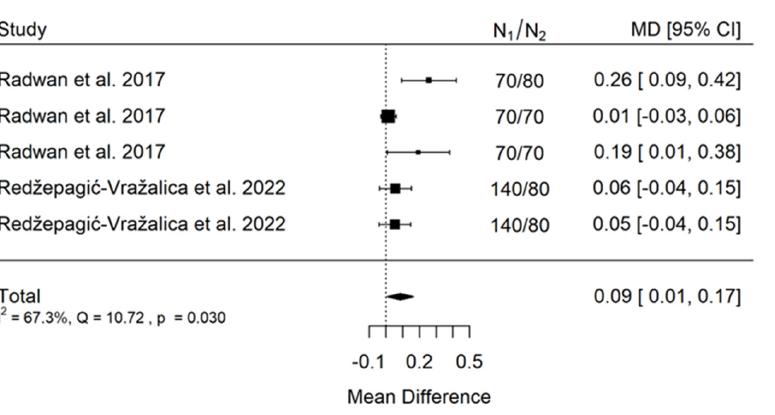
Figure 13. Funel plot for evalutaion of thread shape factor infulence on pull-out strentght in animal bone model studies. 4. Discussion Although there are many systematic reviews concerning different geometric charac- teristics of OMIs, the present paper is the first referring to their minidesign. First of all, it should be pointed out that no clinical study considering the number of threads, threads depth, or TSF has been found in the literature. The only papers found correlating the minidesign of OMIs to their physical characteristics are animal studies, in-vitro studies, and 3D finite element analysis. Thus, the authors of the present systematic review must have based their clinical recommendations on indirect evidence. Moreover, there is a well-designed split-mouth study discussing other factors, that may influence OMI stability, for instance, chemical treatment of screw surfaces [44]. An- other study shows that increasing penetration depth of OMIs results in better retention [45], whereas increased abutment head distance from cortical plate leads to decreased re- tention [45]. Moreover, TADs inclination angle of 60 to 70° to the cortical plate was re- ported as the most retentive insertion angle [46,47]. Insertion at a right angle or more oblique from the line of force reduces retention of TADs. In the present review with meta-analysis, the studies included are characterized mainly by the medium quality of evidence. This may result from the types of studies in- cluded. In the studies included the researchers had a possibility to carefully design every step of a trial, including the study material, procedure, and examination, leaving less pos- sibility of biases than in clinical trials, where the subjects may much more frequently be- have differently than planned. The shortcomings of in-vitro studies included were mainly